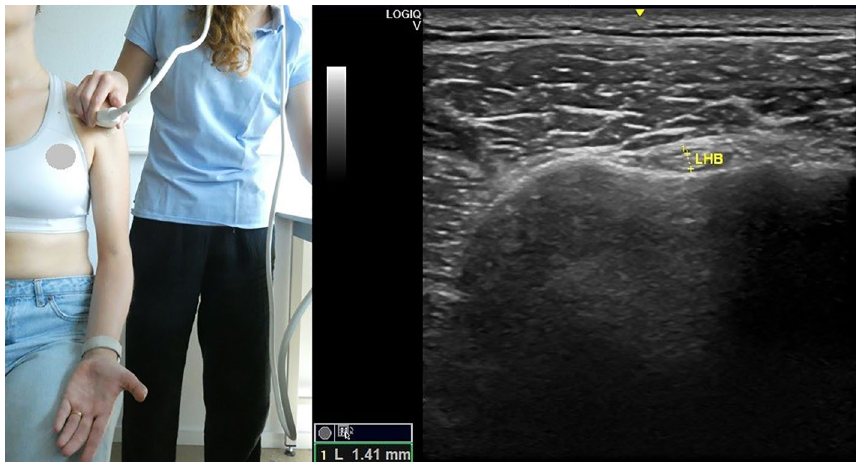
Figure 2. Left: position of the probe and of the subject during the measurement of the long head of the biceps tendon thickness; right: measurement of the long head of the biceps tendon thickness. Photo on the left side by Anthe Foubert.